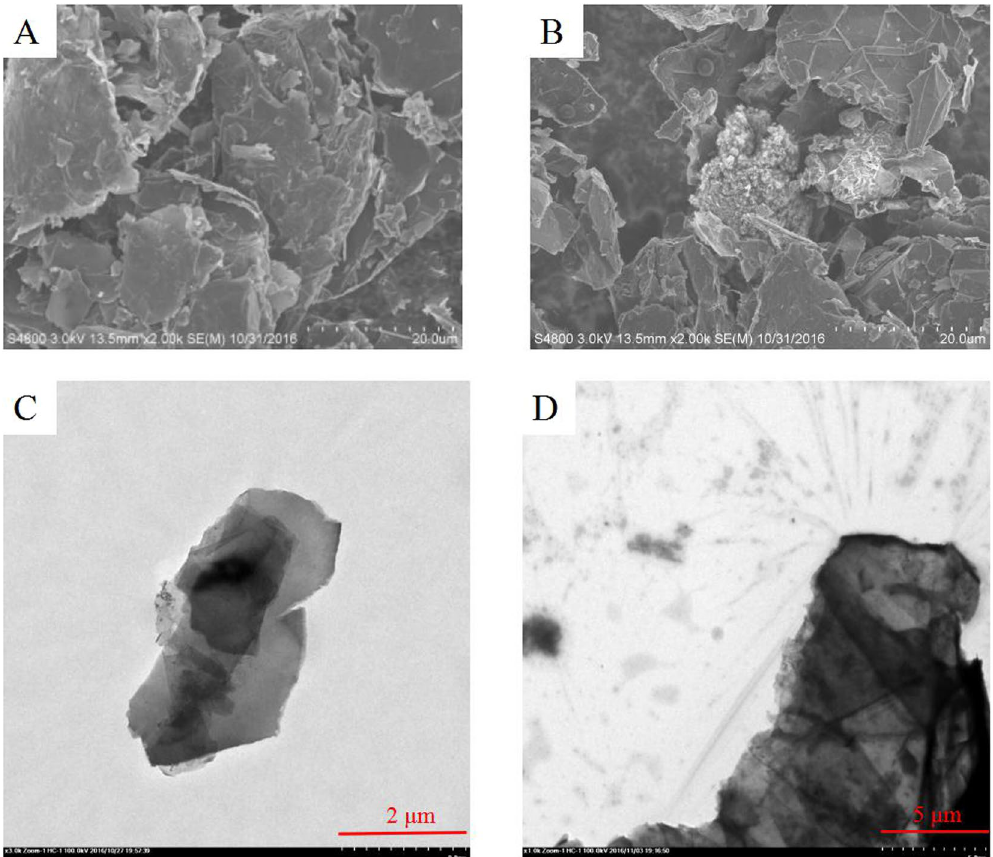
Figure 1. SEM and TEM images of GnPs and GnPs-Danshen tablets, ( A ) and ( B ) show the SEM images of GnPs and GnPs-Danshen tablets, respectively, ( C ) and ( D ) show the TEM images of GnPs and GnPs-Danshen tablets,